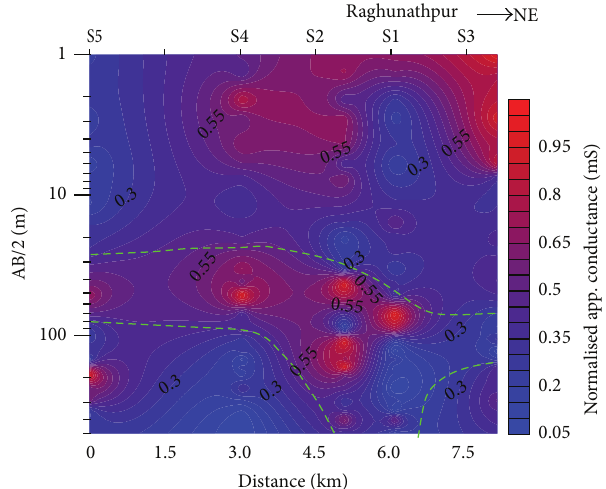
Figure 6: 2D Pseudo section contoured from normalized apparent conductance ( 𝐶 𝐴 ) of five